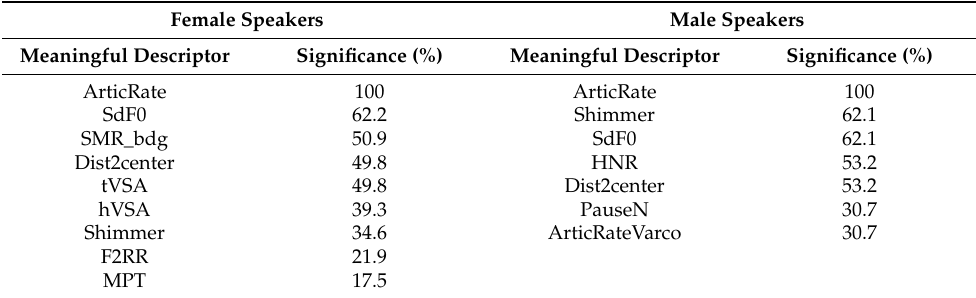
Table 5. Single MARS models (age modelled by all descriptors); one for female (left panel), one for male (right panel) speakers—significance level of meaningful explanatory variables, by order of importance.